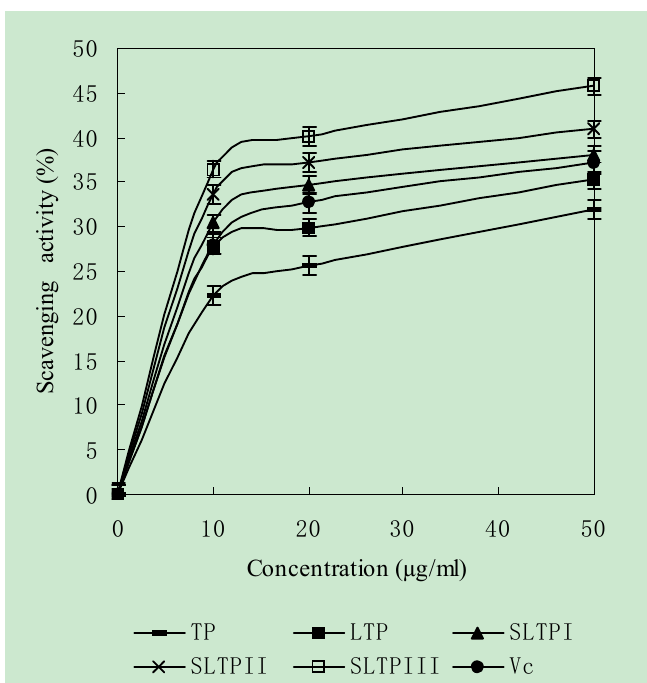
Figure 4. Scavenging activity of natural TP, its derivatives and Vitamin C against superoxide anion radicals. Values were means ± SD (n =